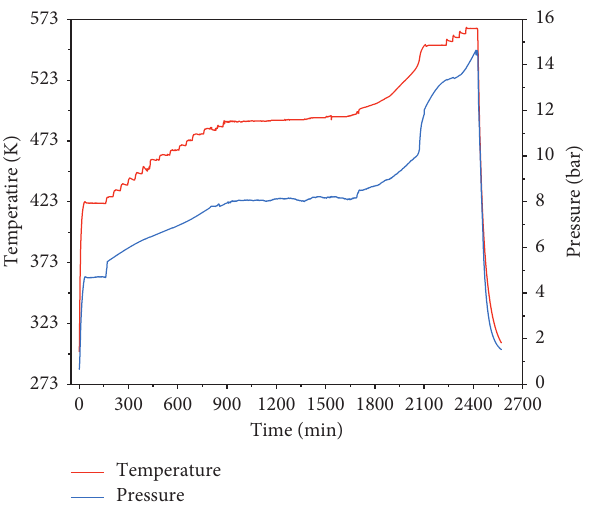
Figure 6: ARC-derived thermal decomposition curve for Grignard reagent.